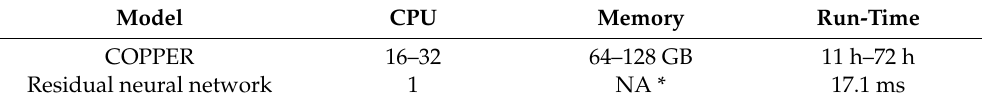
Table 6. Comparison of COPPER and proposed model computational costs and run time. Model CPU Memory